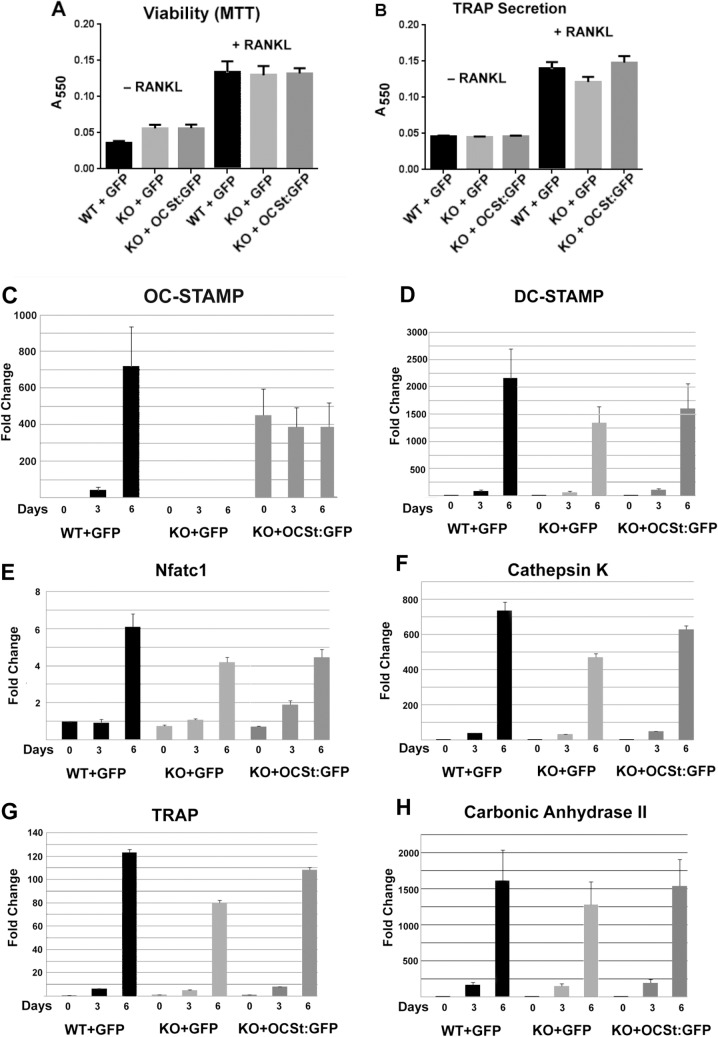
Viability, secretion, and gene expression.
A. Viability. BMMC from wild type (WT) or OCSt-KO (KO) were virally transduced, cultured with or without RANKL for 6 days as indicated, and MTT assays for cell viability were performed. Transduction with either GFP or OC-STAMP-GFP (OCSt:GFP) lentivirus had no effect on viability. Mean + s.d., n = 3. B. TRAP secretion. Supernatants from cells cultured as in A were analyzed for secreted TRAP enzyme. No significant difference in TRAP secretion was seen between wild type (WT) and OCSt-KO (KO) cells, whether transduced with GFP or with OC-STAMP fused to GFP (OCSt:GFP). Mean + s.d., n = 3. C-H. mRNA expression of osteoclast markers. Primary BMMC cells were virally transduced and were cultured for 0, 3, and 6 days in the presence of RANKL, and Q-PCR analyses for osteoclast mRNAs were performed, as indicated. Note that no OC-STAMP mRNA was detected in OCSt-KO (KO) cells at any time point unless the viral vector encoded OC-STAMP (OCSt:GFP), whereas no other osteoclast markers were significantly affected; n = 3.